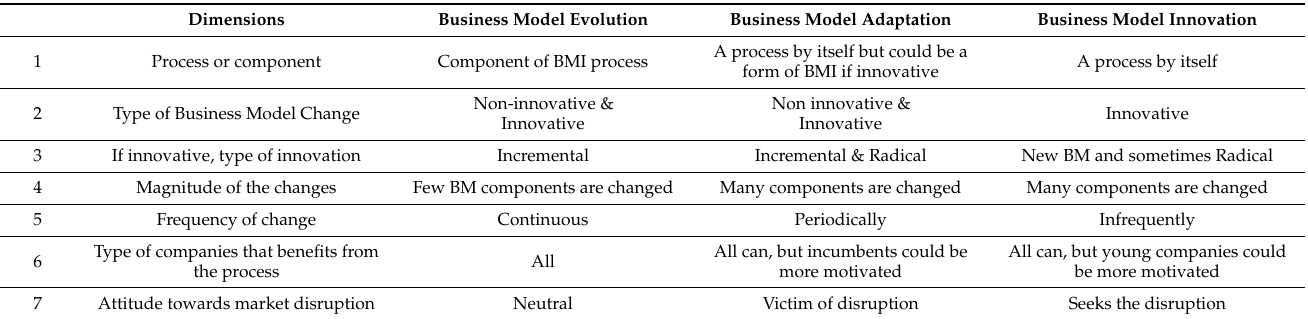
Table 16. Comparing different dimensions of the